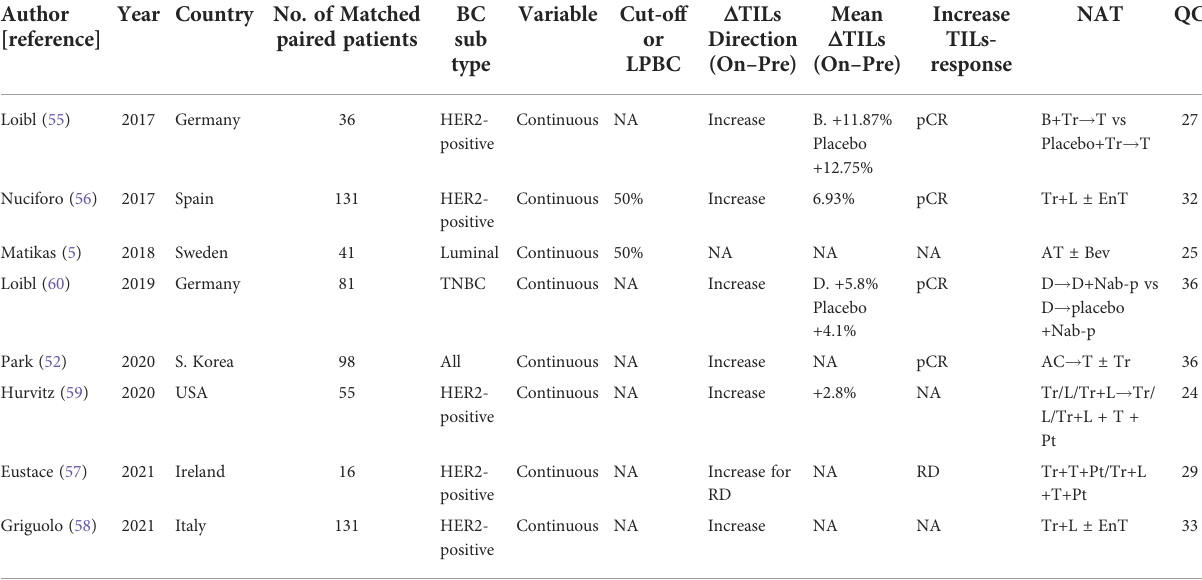
TABLE 4 Studies assessed the expression of on-treatment TILs in matched-paired early breast cancer patients receiving neoadjuvant therapy. Author Year Country No. of Matched [reference] paired